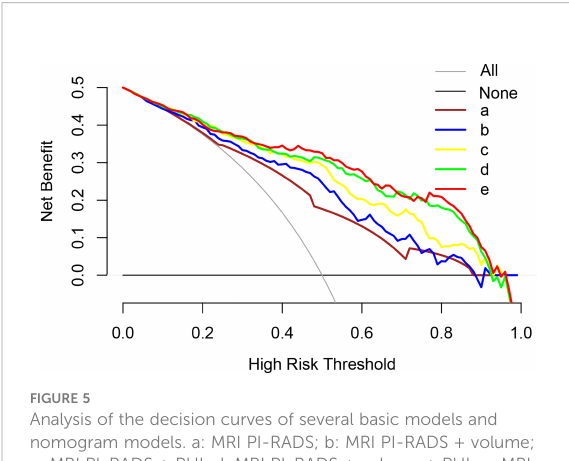
FIGURE 5 Analysis of the decision curves of several basic models and nomogram models. a: MRI PI-RADS; b: MRI PI-RADS + volume; c: MRI PI-RADS + PHI; d: MRI PI-RADS + volume + PHI; e: MRI PI-RADS + volume + PHI + fPSA (Nomogram model). PI-RADS, Prostate Imaging Reporting and Data System; tPSA, total prostate-speci fi c antigen; PHI, prostate health index.